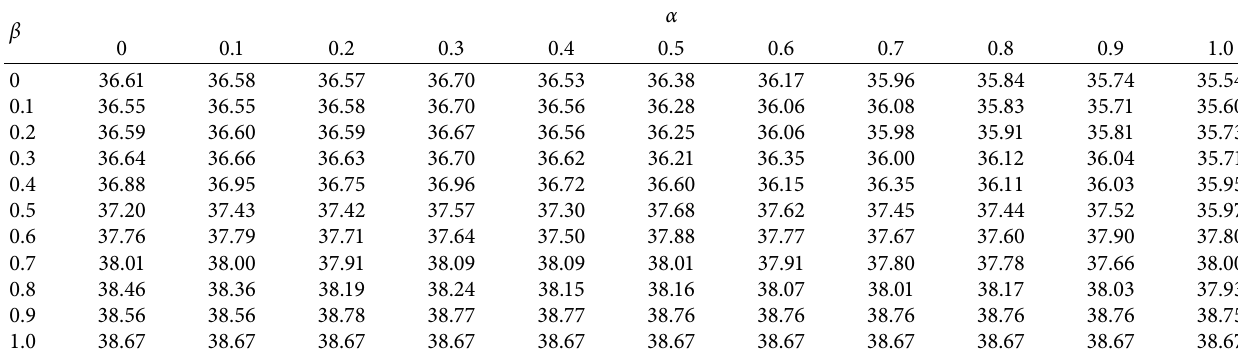
Figure 2: Changing diagram of road network capacity under different market penetration. (a) CAVs and HDVs-II. (b) CAVs and HDVs-I. (c) HDVs-I and HDVs-II. Table 7: Average travel time under different market penetration